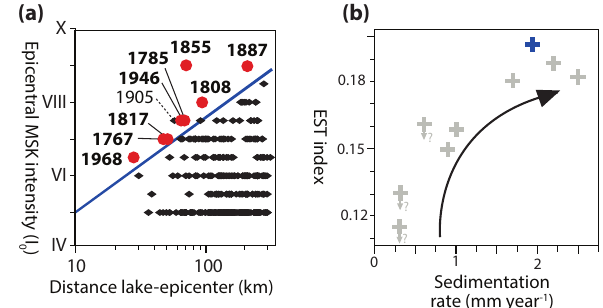
Figure 8. (a) Diagram of the distance of earthquakes to the lake vs. epicentral MSK intensity to confirm that the earthquakes associated with the mass-movement-induced deposits are the strongest and/or the closest to the lake. Black crosses indicate all historic earth- quakes closer than 120km to the lakes with epicentral MSK intensi- ties ≥ IV. Red dots with dates correspond to historical earthquakes associated with the mass-movement-induced deposits in Fig. 7. The sensitivity threshold (blue line) is placed to delimit the recorded from the non-recorded earthquakes. (b) The Earthquake Sensitivity Threshold Index (ESTI) is compared to the sedimentation rate for Lago Inferiore de Laures (blue cross) and other similar Alpine lakes (grey crosses) studied by Wilhelm et al. (2016b). Arrows show that these ESTIs are maximum